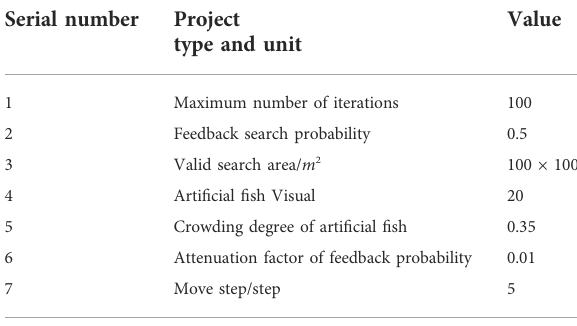
TABLE 2 Relevant parameters of quantum arti fi cial fi sh swarm algorithm.